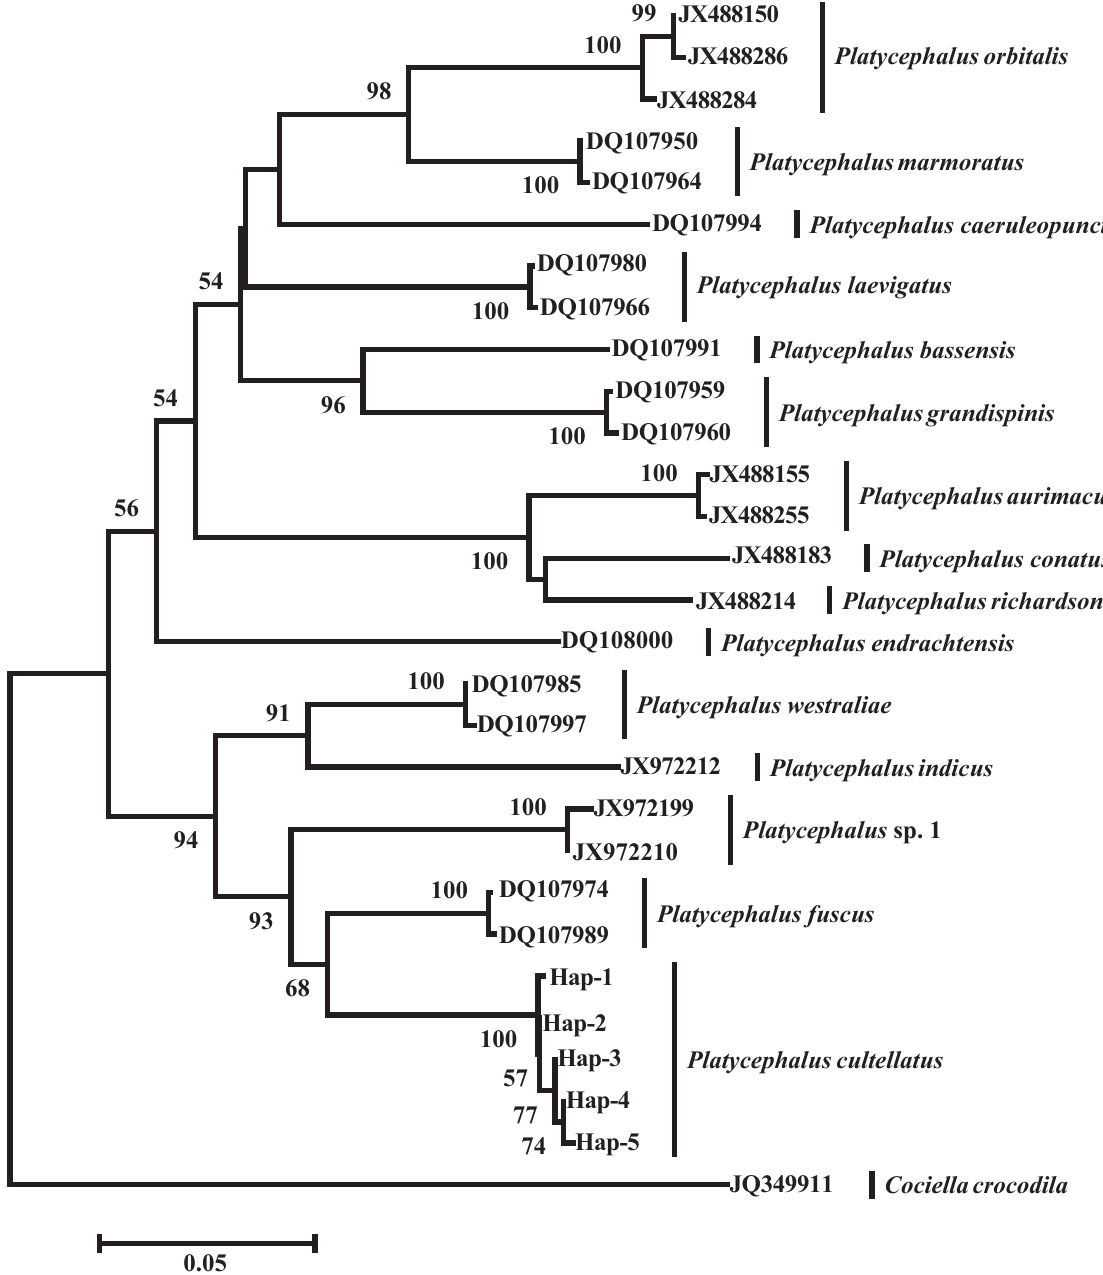
Fig. 3. Phylogenetic tree based on neighbor-joining analysis of COI sequence. Cociella crocodila (JQ349911) was chosen as the out-group to root the tree. Numbers above branches indicate neighbor-joining bootstrap percentages. Only Bootstrap values of > 50% are shown in the NJ